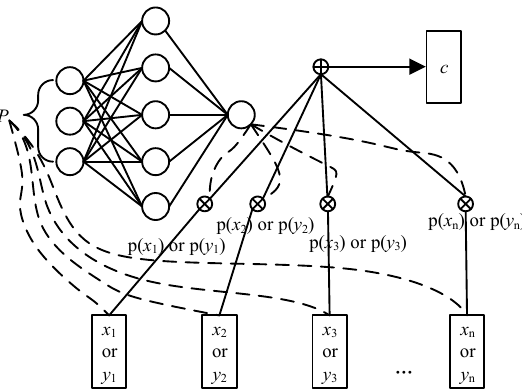
Figure 3. fusion mechanism. Figure 3. Fusion mechanism.